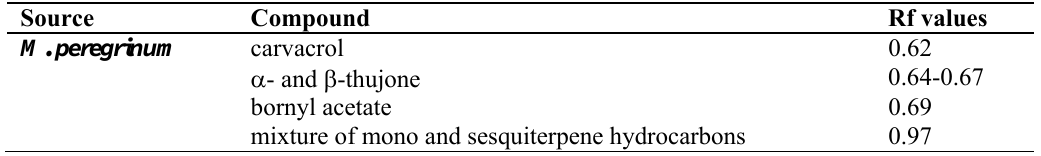
Table 3. DPPH Scavenging Active Compounds Identified by the TLC Dot-Blot